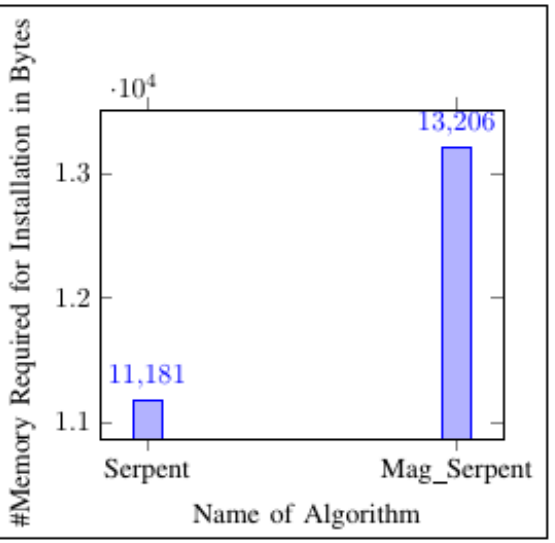
Figure 17. Memory required for installation in